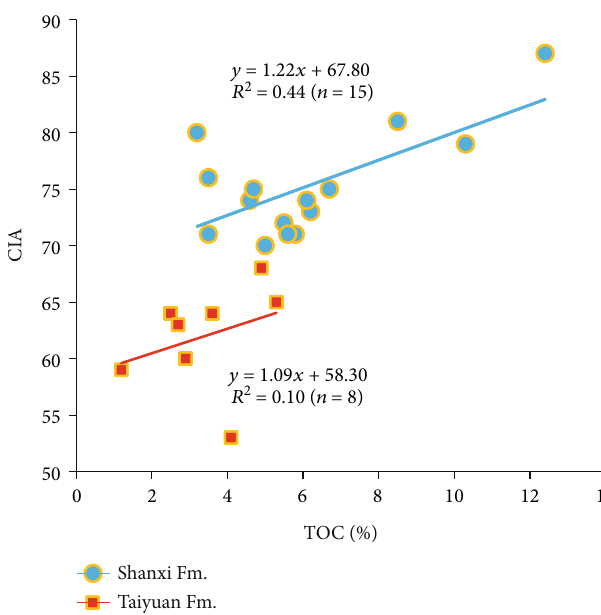
Figure 4: Crossplots of TOC content versus CIA of the samples in the Taiyuan and Shanxi